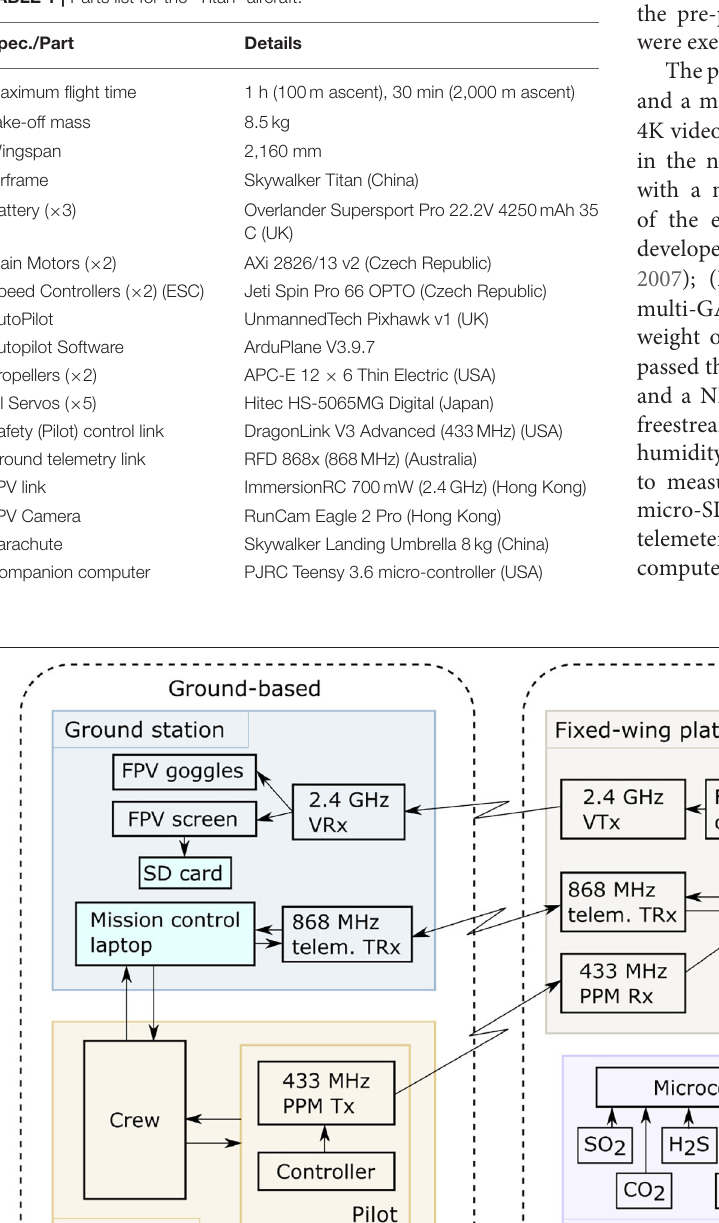
Frontiers in Robotics and AI |